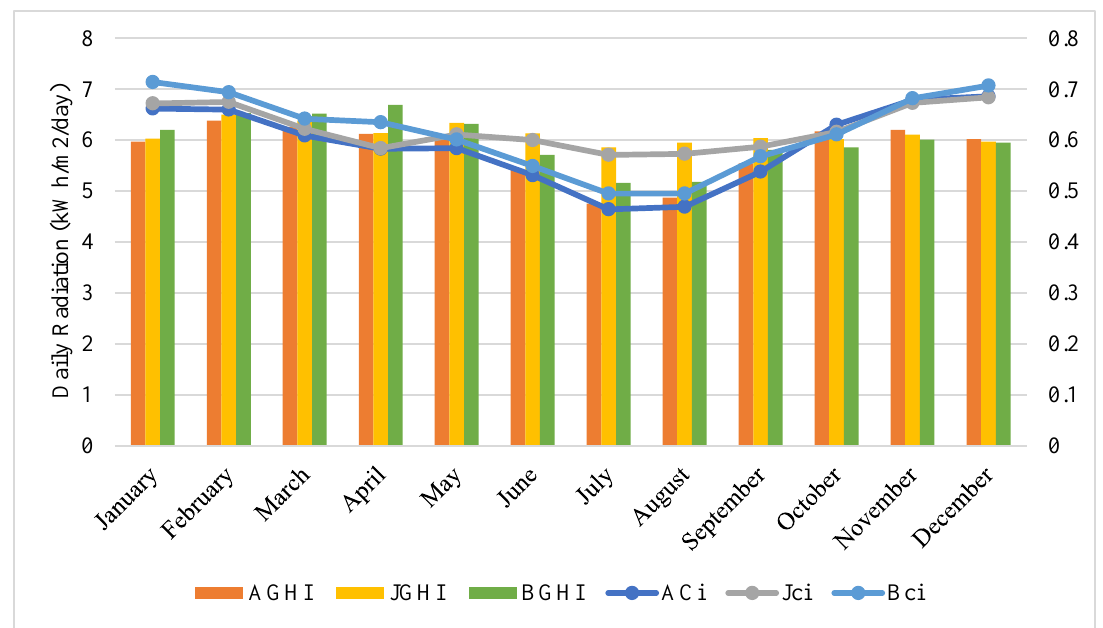
Figure 2. Monthly average solar irradiation for three cities in Ethiopia. AGHI, JGHI, BGHI and ACi, JCi, BCi are the Daily Radiation and Clearness Index of Addis Ababa, Jijiga and Bahir Dar, respectively.